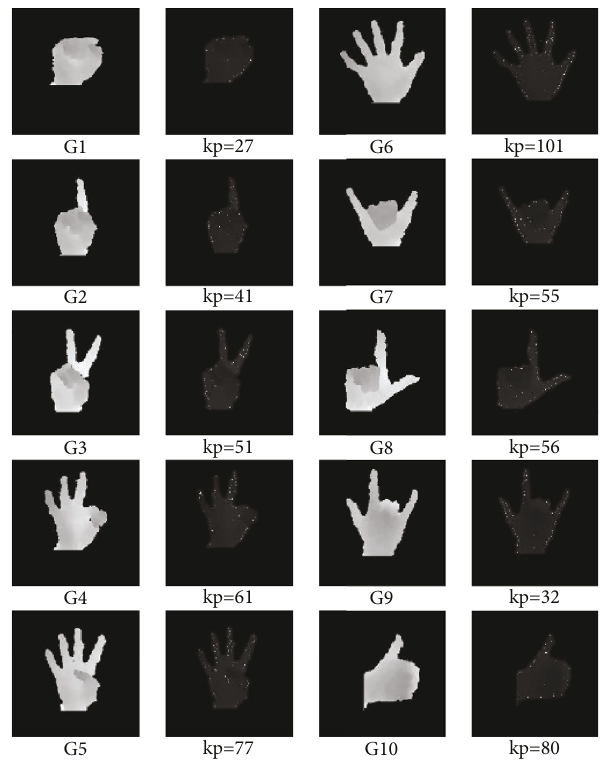
Figure 4: Example images containing generated depth silhouettes (first and third columns) and the corresponding SIFT keypoints mapped in to depth images (second and fourth columns) showing numeric symbols (0-9) representing the gestures (G1-G10).